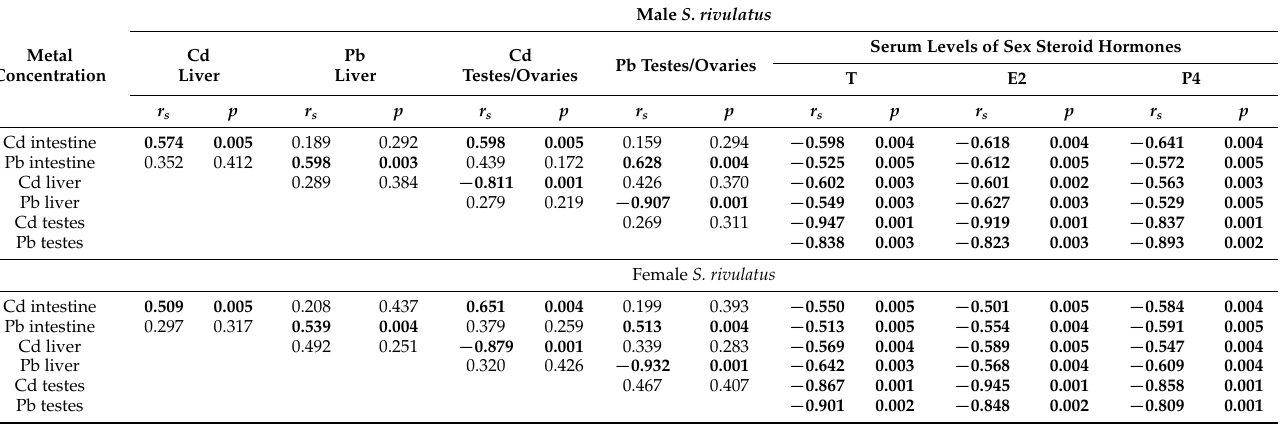
Table 4. Spearman’s rank correlation ( r s ) matrix between mean metals concentrations in the in- testine, liver, and gonads of S. rivulatus , and between these concentrations and serum levels of sex steroid